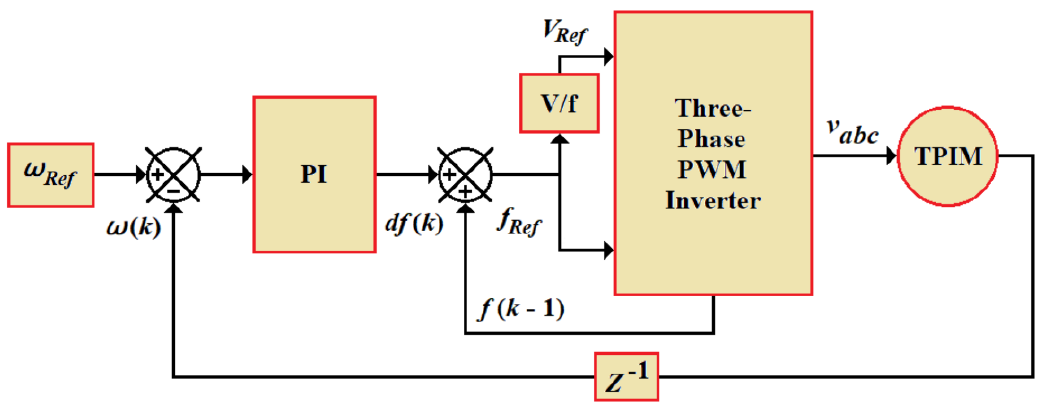
Figure 3. Block illustration of the V/f drive of three-phase induction motor [23].